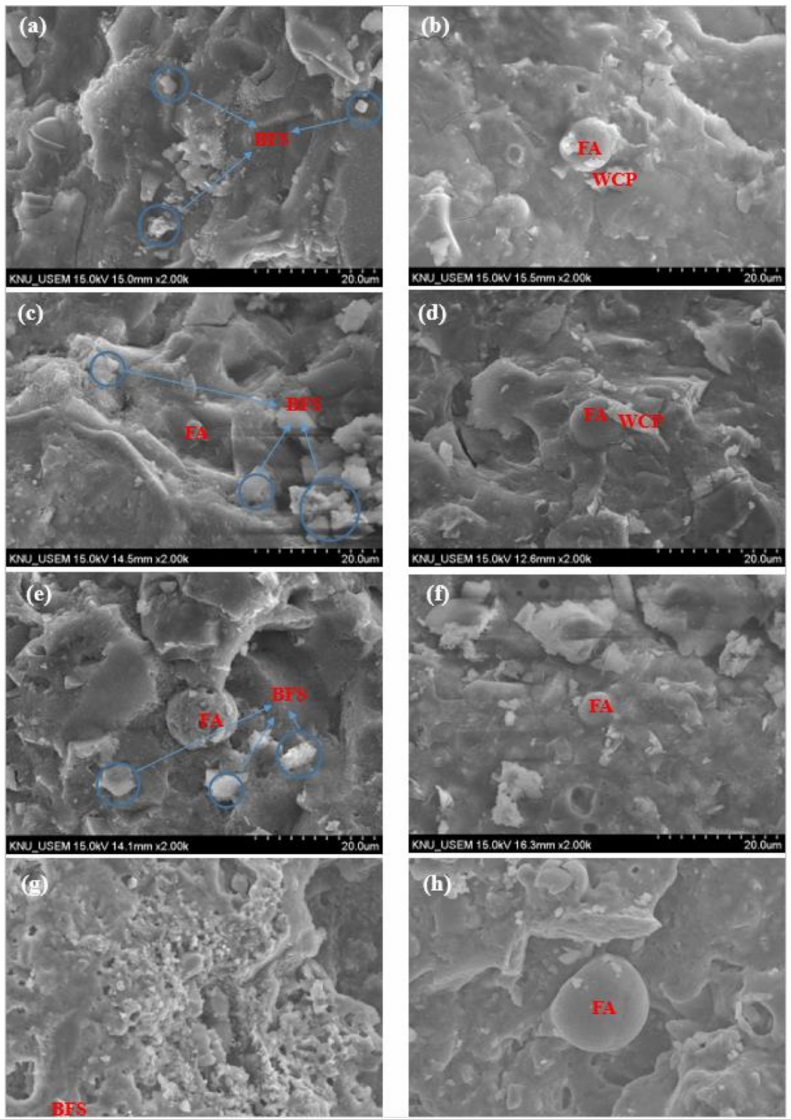
Figure 10. SEM images of WCP-0 and WCP-20 magnified 2000 times before and after heating. ( a ) WCP-0, 45 ◦ C; ( b ) WCP-20, 45 ◦ C; ( c ) WCP-0, 300 ◦ C; ( d ) WCP-20, 300 ◦ C; ( e ) WCP-0, 600 ◦ C; ( f ) WCP-20, 600 ◦ C; ( g ) WCP-0, 900 °C; ( h ) WCP-20, 900 ◦